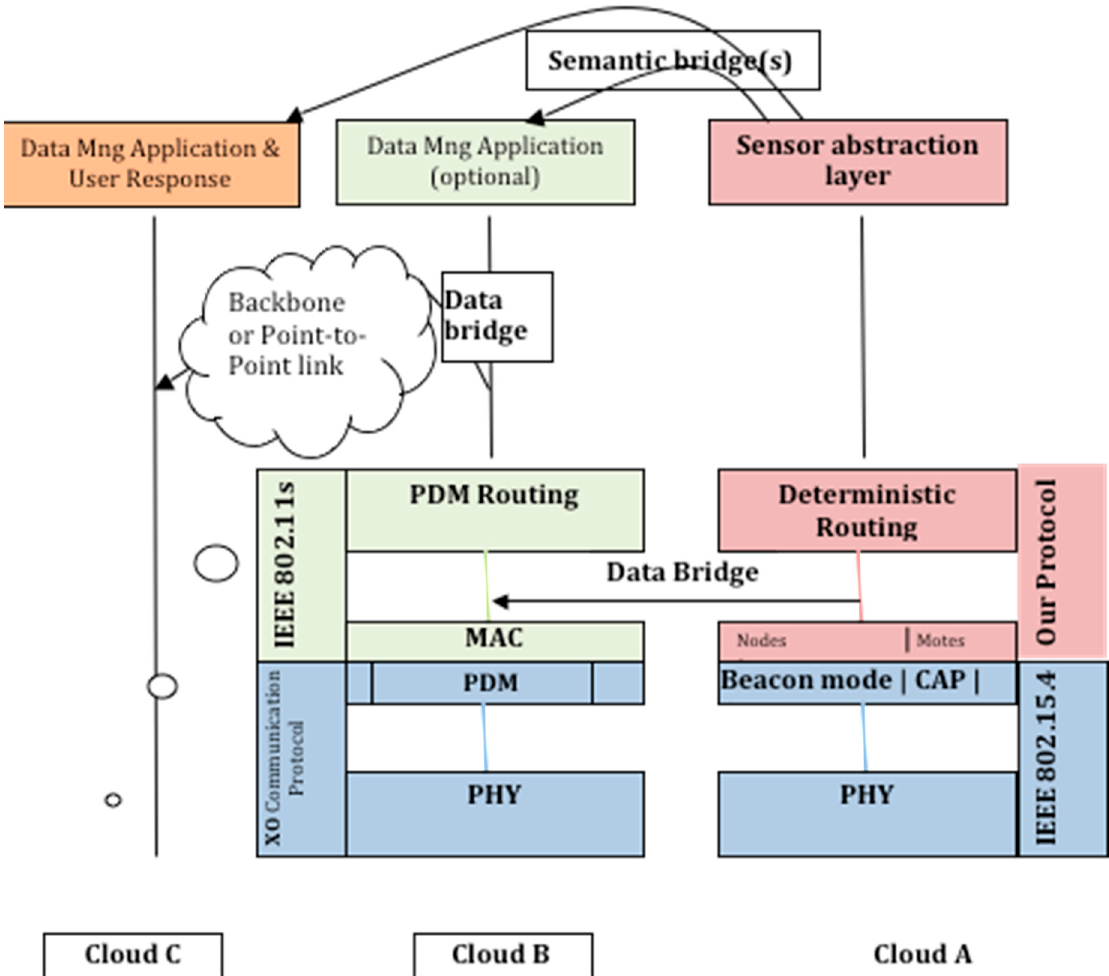
Figure 2. Protocol architecture. Arrows represent cross layer bridges.